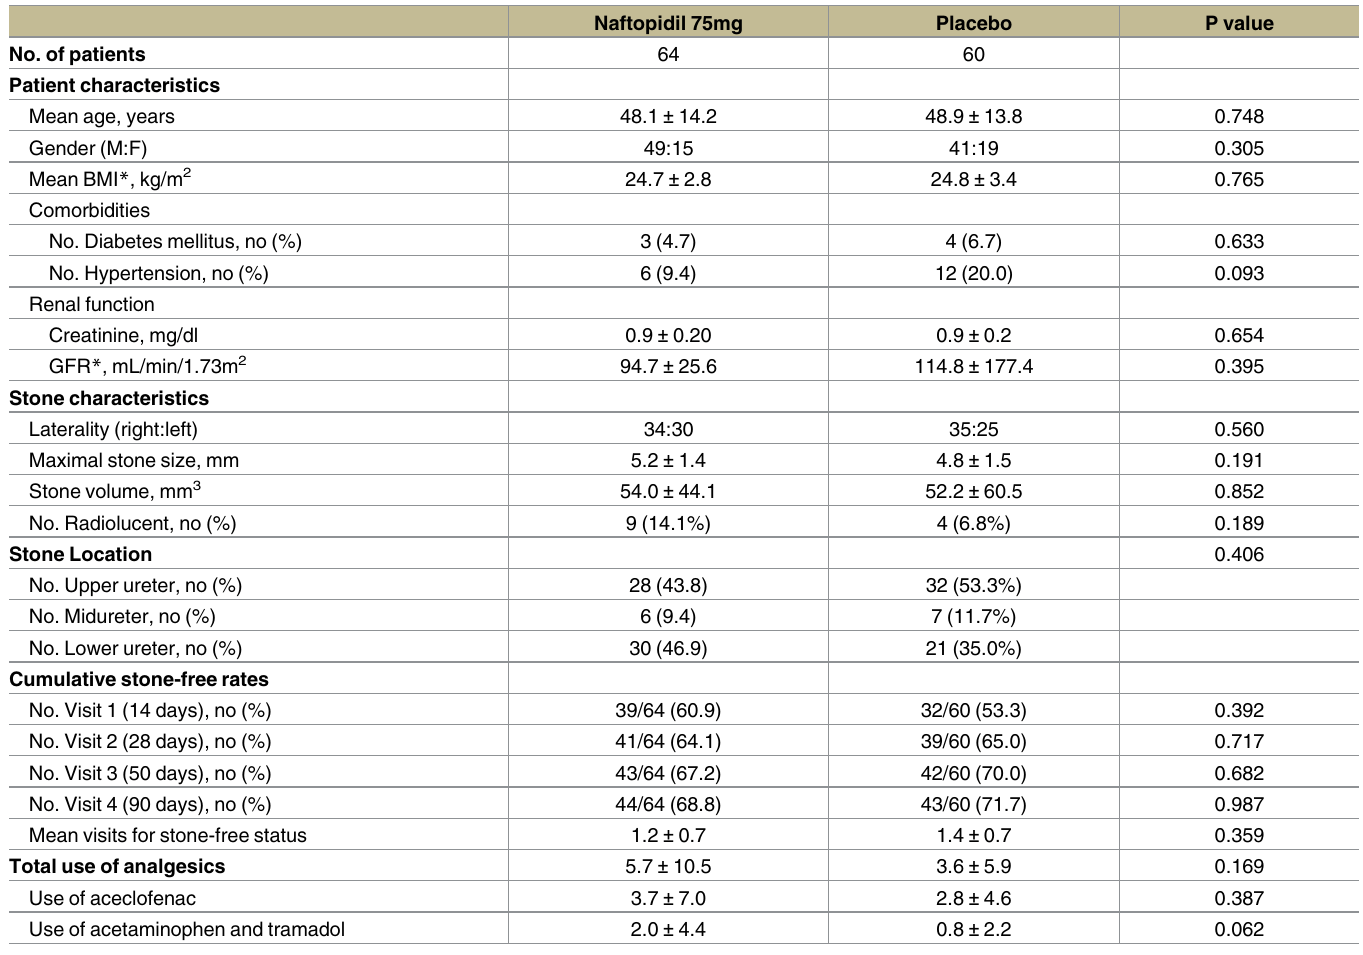
Table 1. Patients and stone characteristics (per protocol set at visit